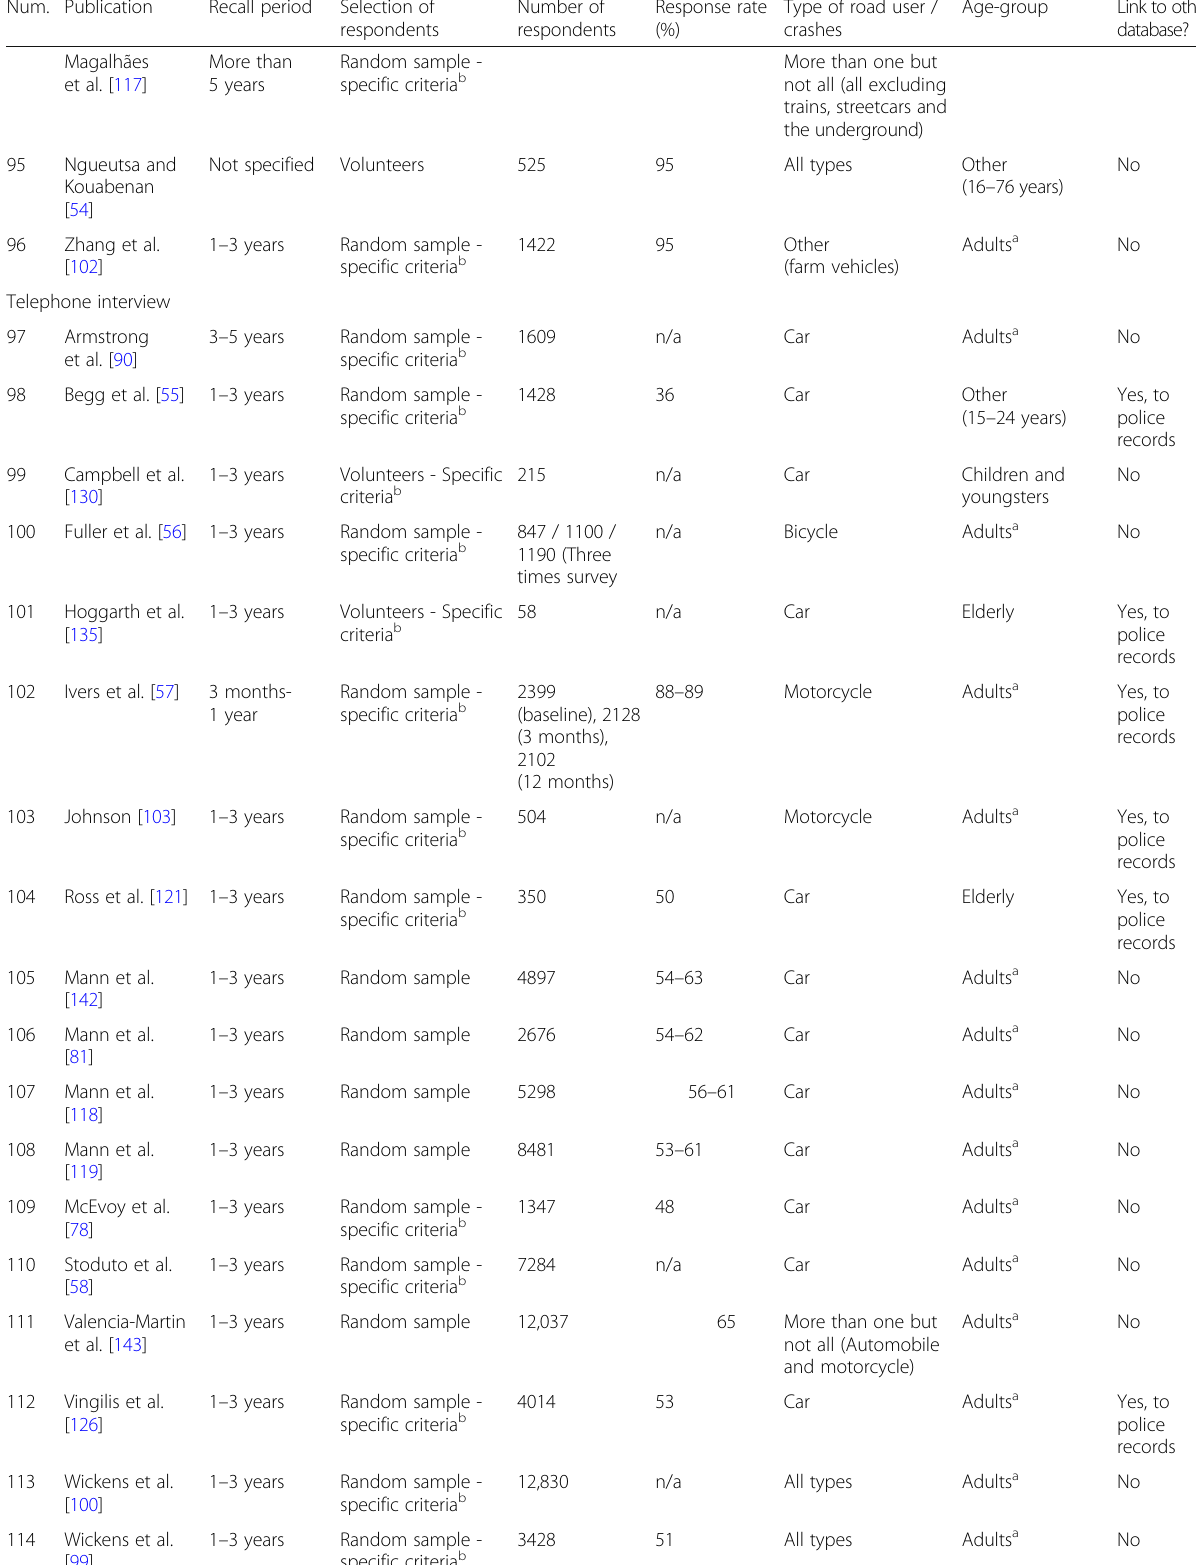
Table 2 Summary of the studies reviewed based on method